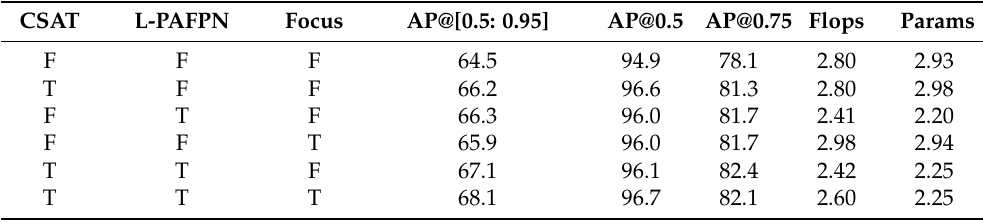
Table 7. Ablation experiment on the